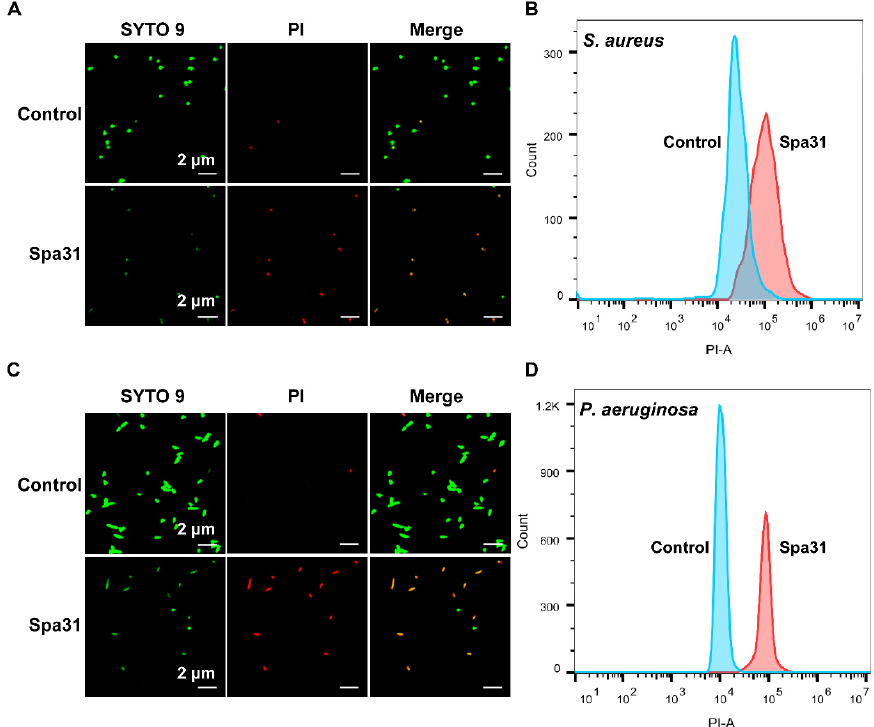
Figure 4. The permeability of Spa31 on the bacterial inner membrane of S. aureus and P. aeruginosa . The fluorescence signals of SYTO 9 (green) and PI (red) in S. aureus ( A ) and P. aeruginosa ( C ) observed by confocal laser scanning microscope. The fluorescence intensities of PI in S. aureus ( B ) and P. aeruginosa ( D ) detected by flow cytometry.